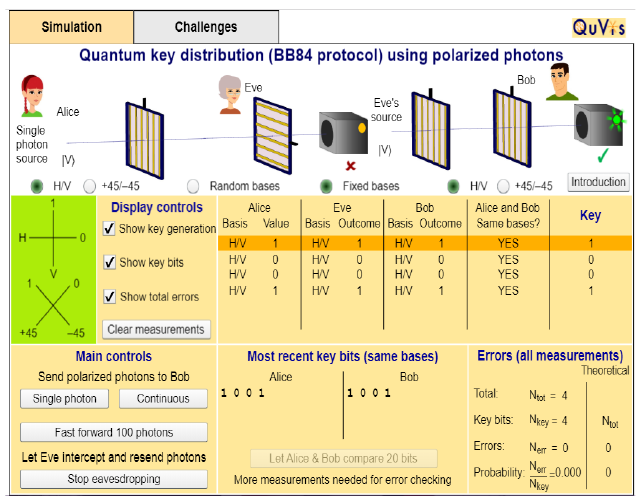
Figure 4. Session not captured and data received successfully